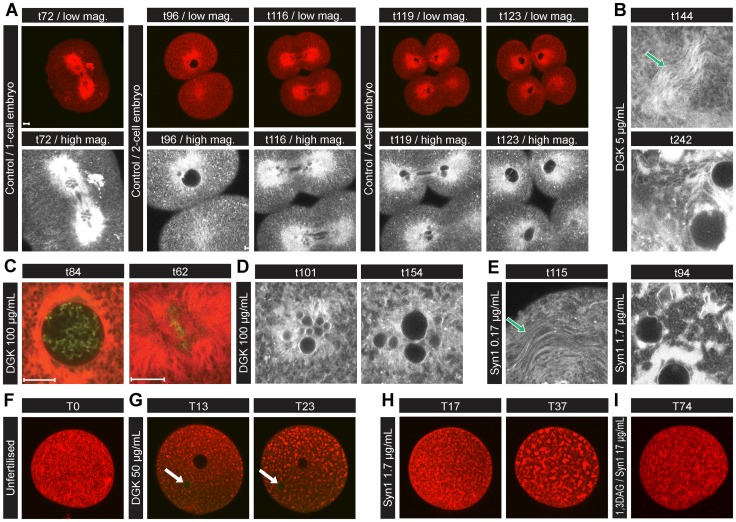
Effects of DGK and Synaptojanin1 microinjection on sea urchin embryos and eggs.(A) Fertilised eggs. The ER was labelled by microinjection of DiIC18 into sea urchin eggs between 10–25 min post fertilisation. Karyomeres in the first cell cycle resolve into individual nuclei between 72 and 96 min post-fertilisation and in the second cycle (4-cell stage) between 116 and 123 min. (B) At 5 μg/ml pipette concentration of DGK, curved stacked sheets of ER formed by 144 min that coalesced into more concentrated “aggregates”. (C) At 100 μg/ml of DGK, either chromosomes condensed but the NE did not break down or an apparently normal metaphase occurred but karyomere fusion (D) was greatly retarded compared to the first cycle controls. (E) Synaptojanin 1 (Syn1) induced a similar phenotype of karyomere resolution delay to DGK as well as formation of curved stacked sheets of ER that coalesced into “aggregates” of sheets (0.17 μg/ml and 1.7 μg/ml shown). Unfertilised haploid eggs (F) were injected with either 50 μg/ml DGK (G) or 1.7 μg/ml Syn1 (H) which rapidly converted the ER in a progressive coarsening of the pattern similar to fertilised eggs already detectable by 13 or 17 minutes post-injection (Movie S9). The upper dark circle in (G) images is the injected oil droplet; lower green circle (arrow) is the zygote nucleus with NE that does not undergo breakdown. (I) Unfertilised eggs were incubated with SUVs containing PtdCho and 1,3 DAG (80∶20 mole%) prior to Syn 1 injection (17 μg/ml) at T0. Their appearance did not change for more than 74 min (Movie S10). All embryos were injected with enzymes ∼40 min post-fertilisation. YOYO®-1 iodide was included to label nucleic acid green and monitor injection. Scale bars: 10 μm.